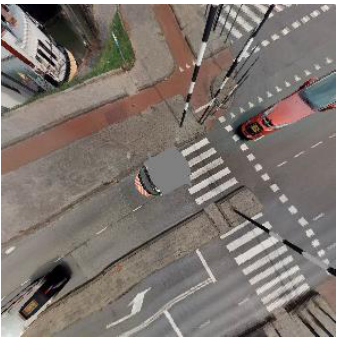
Figure 2 Panoramic projected onto an artificial ground plane